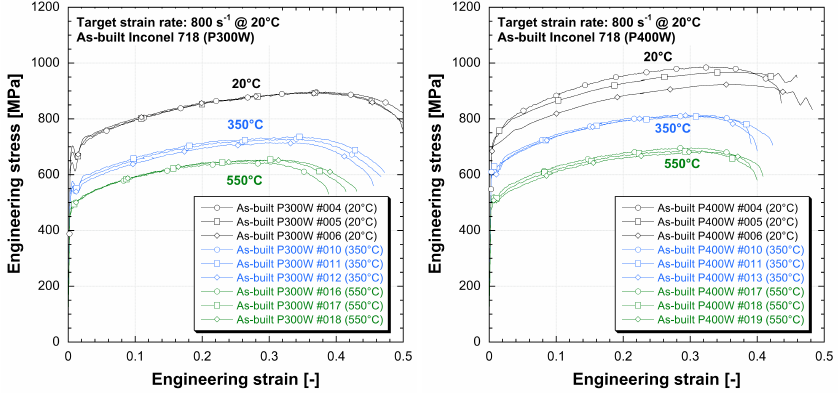
Figure 5: Engineering flow stresses for both as-built materials at the same target strain-rate and di ff erent